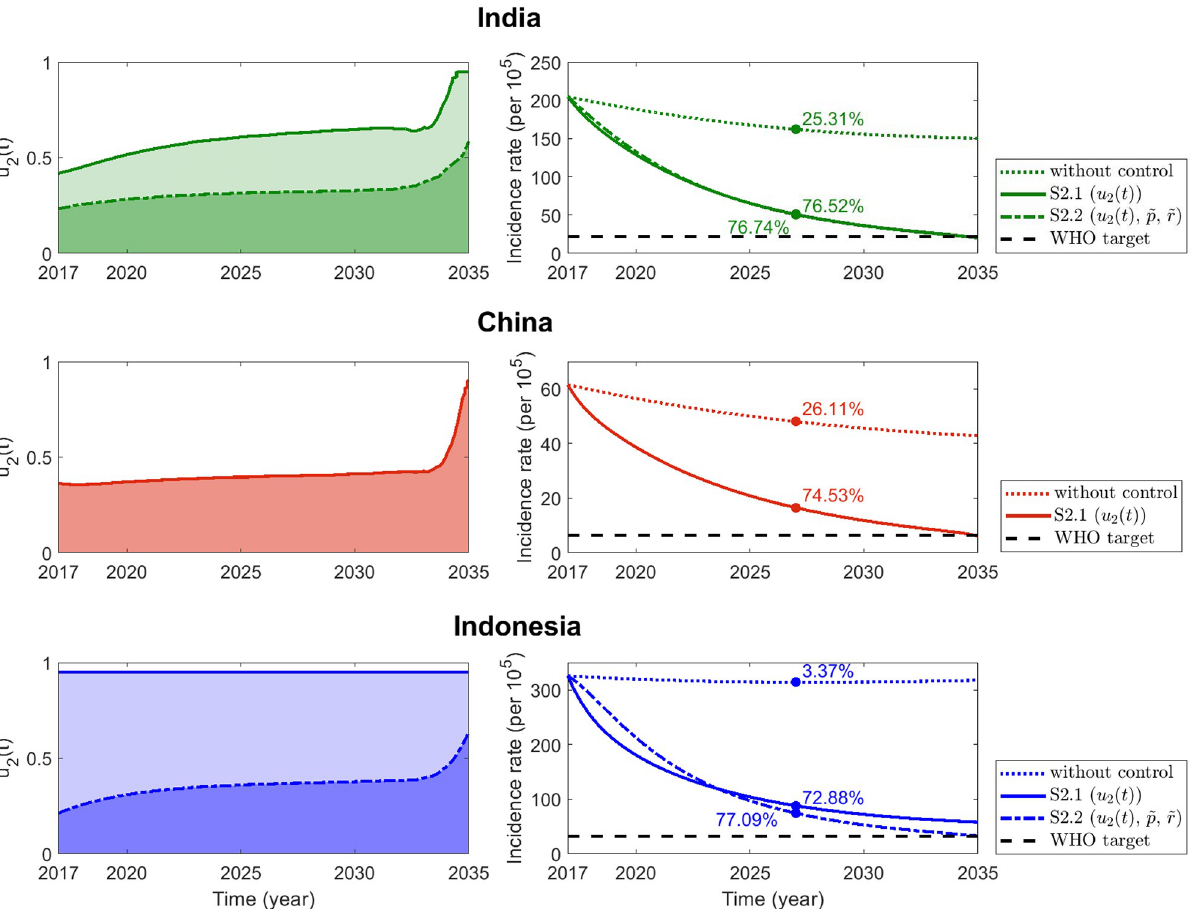
Fig 7. Scenario 2: Latent case finding control strategy. Optimal control strategies with constant case holding and active case finding controls (dash- dotted) or without the two constant controls (solid) are displayed as functions of time in the left frames. The right frames show the corresponding incidence rates and the WHO 2035 targets (black dashed